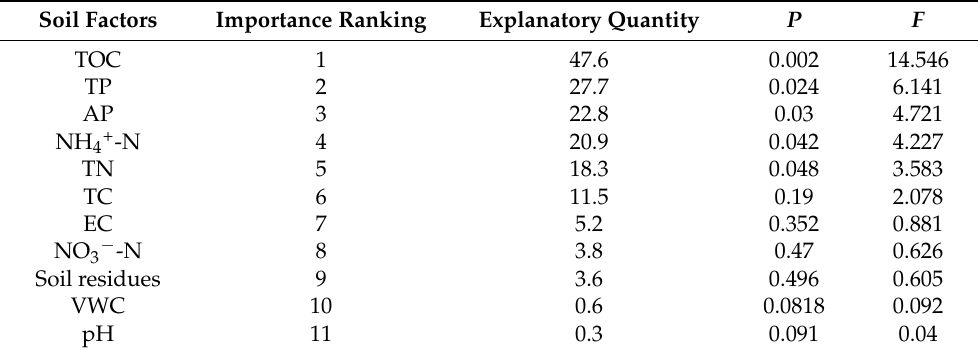
Table 4. Importance ranking and significance of soil factors in their explanation of the overall bacterial diversity of all soil